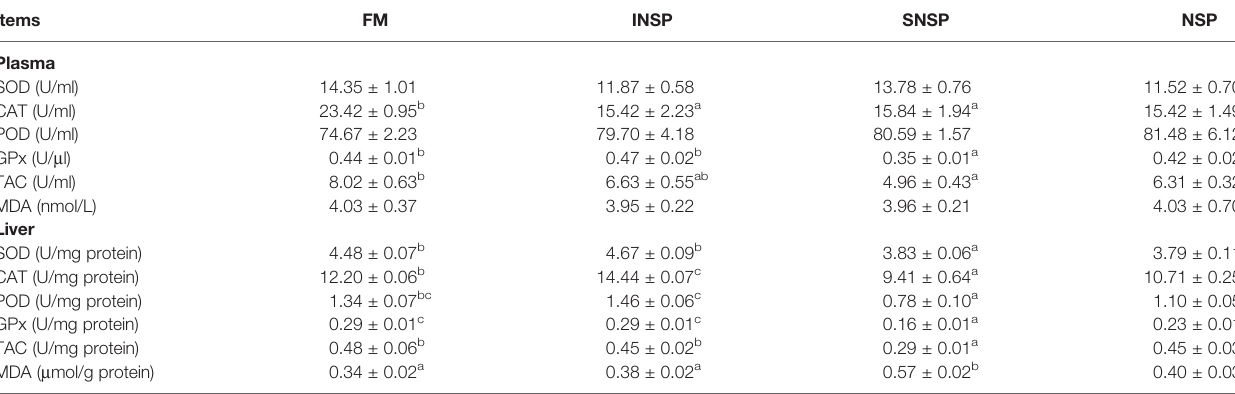
TABLE 6 | Antioxidant capacity of GIFT tilapia fed diets with different types of non-starch polysaccharides. Items